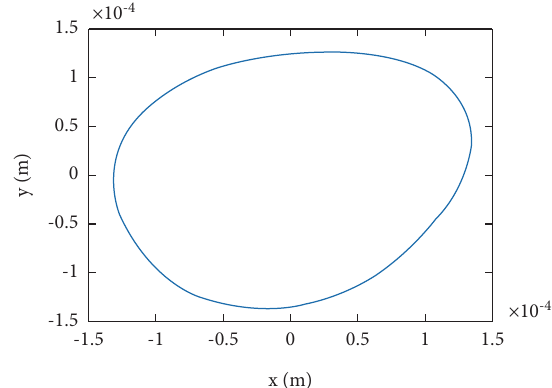
Figure 20: Theoretical vortex